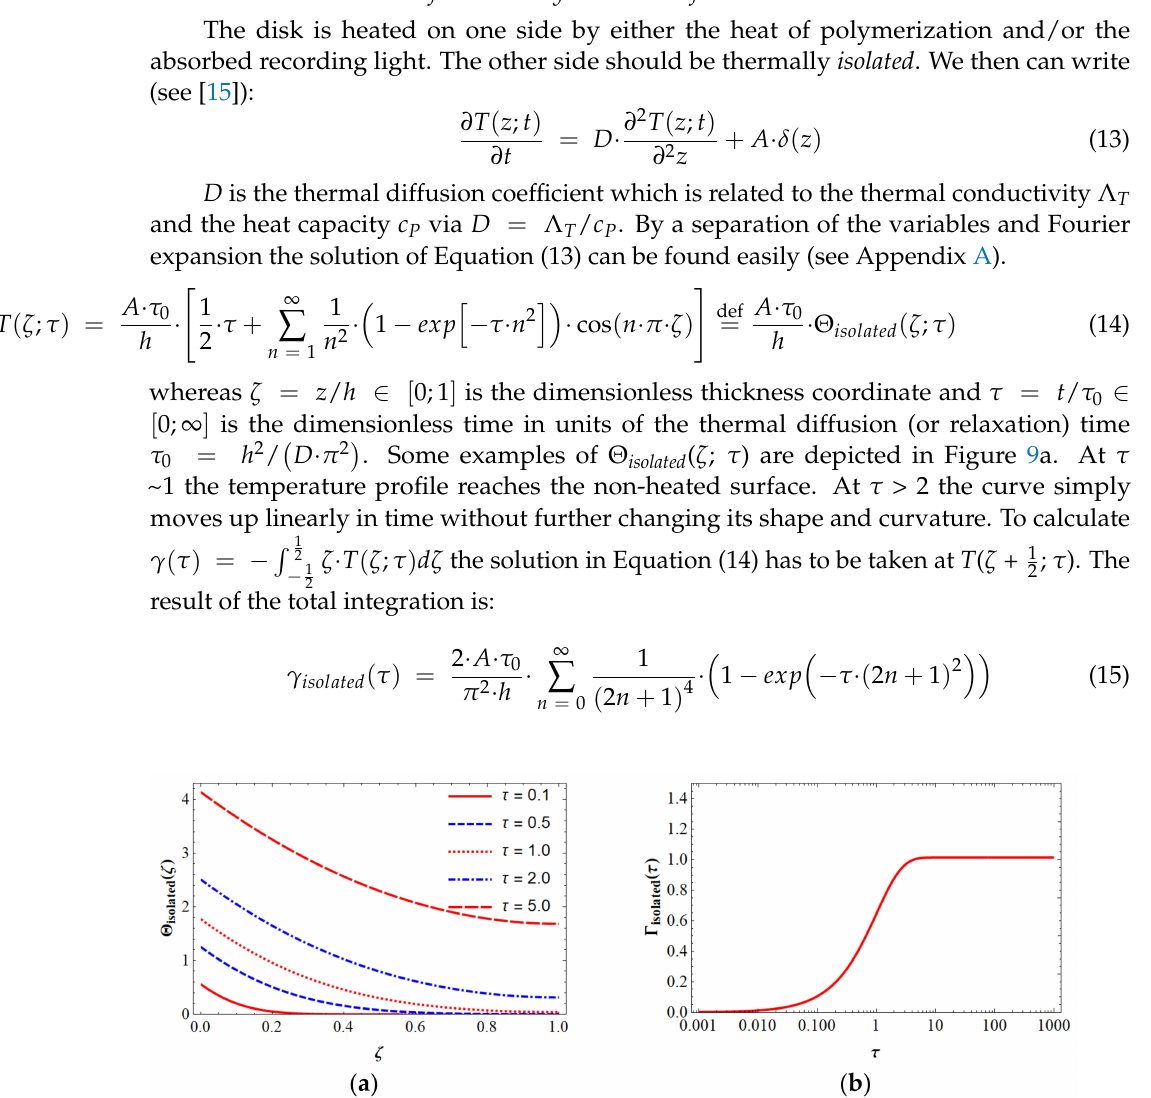
Figure 9. ( a ) The temperature profile Θ isolated ( ζ ; τ ) at values of τ = 0.1, 0.5, 1, 2 and 5. ( b ) The transient behavior of Γ isolated ( τ